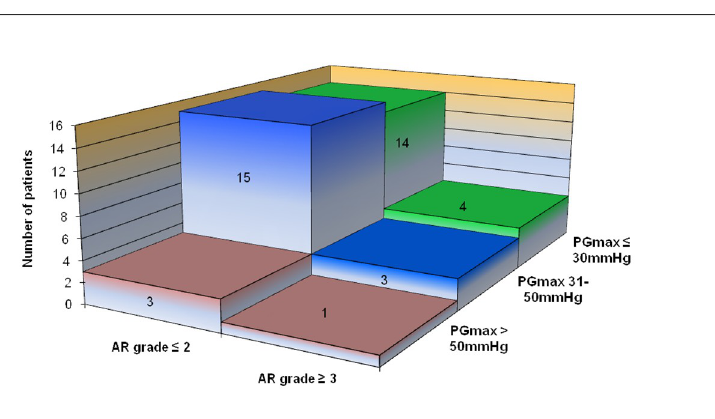
Fig 1. Characteristic of the study group in regards to the occurrence of PG max and AS. Abbreviations–see in Table 2.